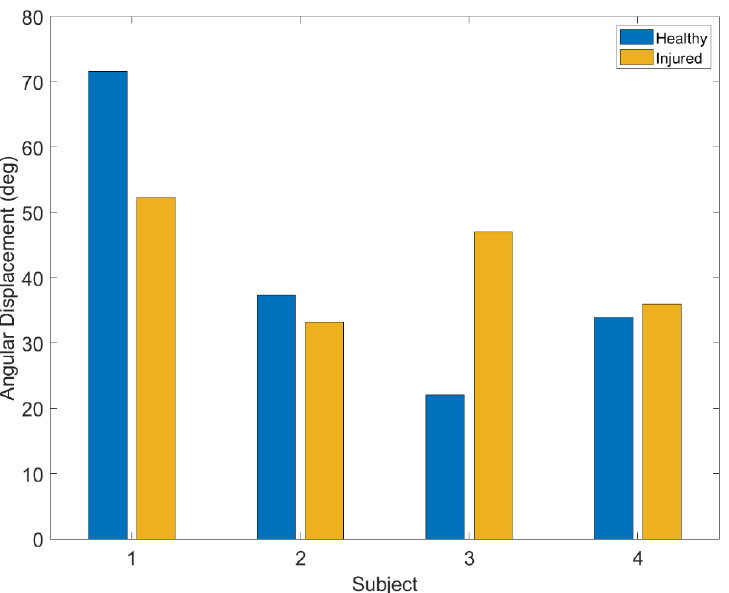
Figure 11. Angular displacement of the IE of healthy and the injured knees for each tested subject during the PS test.